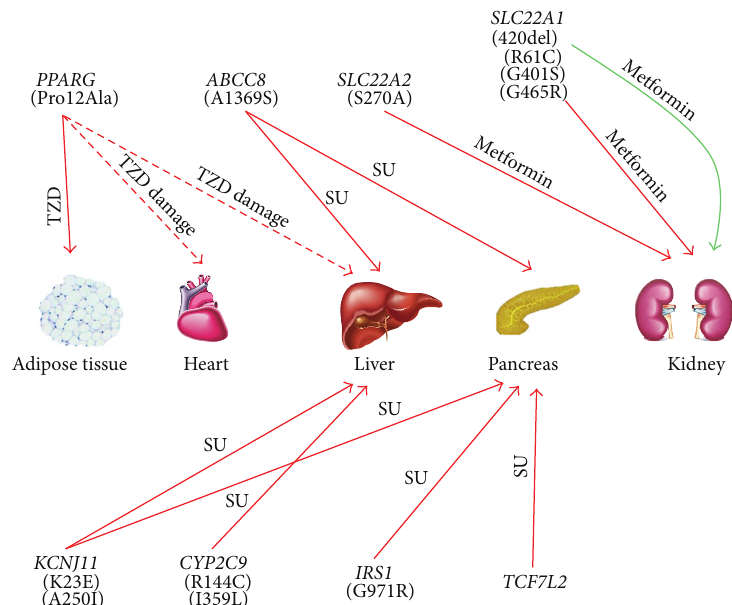
Figure 1: Interactions between gene products and OADs on target organs. Genes and the related “at-risk” SNPs (in brackets) are shown in the upper part. Arrows indicate if a SNP has a negative impact on the responsiveness to a given drug in a specific organ. Red arrows indicate increased drug resistance (or altered drug metabolism), whereas green arrows indicate a beneficial effect of such a SNP. Dashed lines indicate